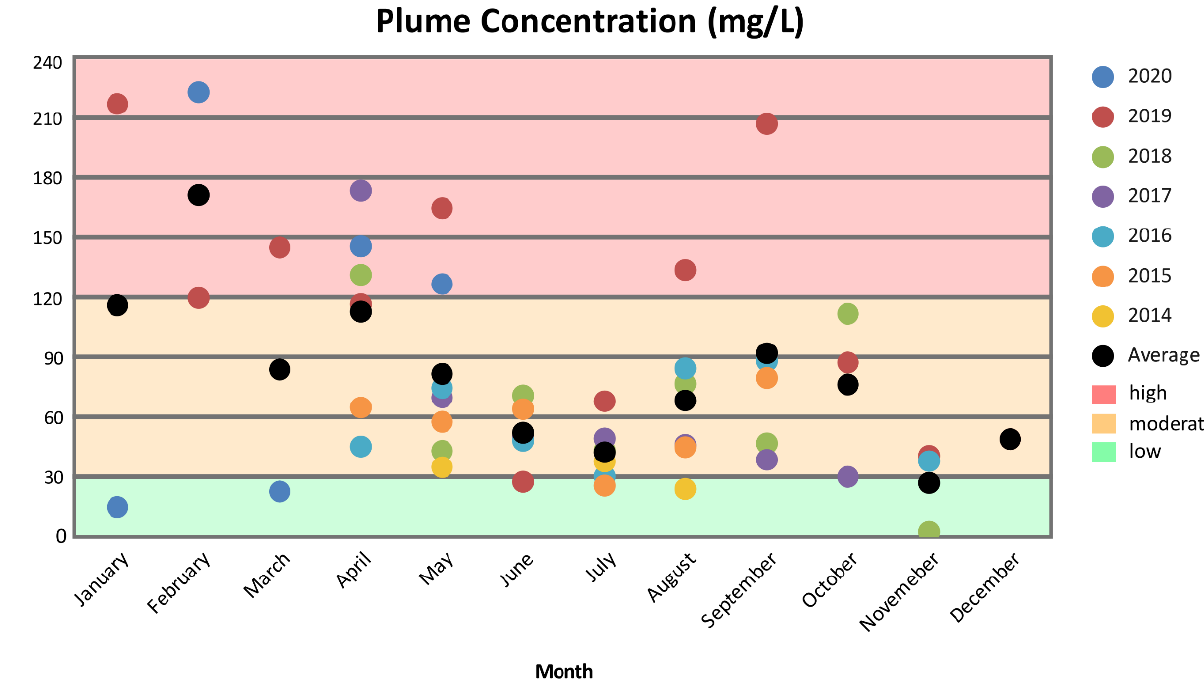
Figure 4. Suspended sediment concentration in the Peace River plume (mg/L) by month from 2014 to 2020 obtained via satellite imagery analysis. Plume activity is indicated by colour shading (see text for explanation).